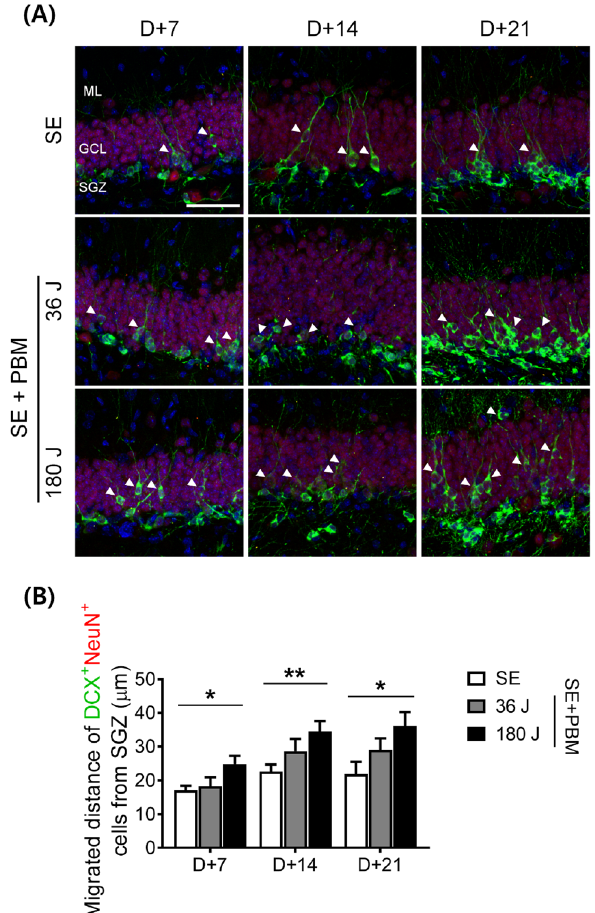
Figure 6. PBM increased early neuronal cell migration from the SGZ to the GCL of the hippocampus after SE. ( A ) Representative coronal section views of Z-stacks obtained by confocal microscopy show the localization of DCX positive cells in the SGZ of the hippocampal dentate gyrus. Immunostaining was performed with DAPI (for nucleus, Blue), NeuN (for mature neuron, red), and DCX (for immature neuron, green). The white arrowhead indicates the appropriate migrating DCX positive cells from the SGZ to the GCL. Scale bar, 100 µm. ( B ) Quantification of the migration distance of DCX positive cells are shown. 180 J PBM treatment statistically increased migration distance compared to SE only at all time points. The quantitative data are presented as the mean ± SEM. *P < 0.05 and **P < 0.05 compared with to SE group. This figure was generated with Microsoft Visio version 2016 (Microsoft, Redmond, WA,